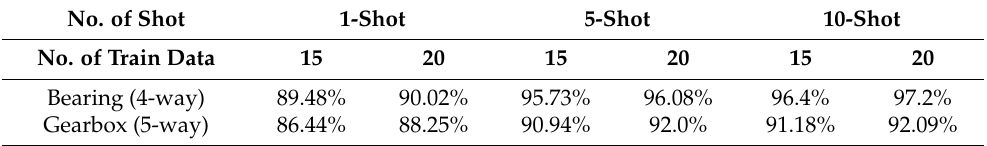
Table 7. The effect of the number of training samples on the results for wind turbines data. No. of Shot 1-Shot 5-Shot 10-Shot No. of Train